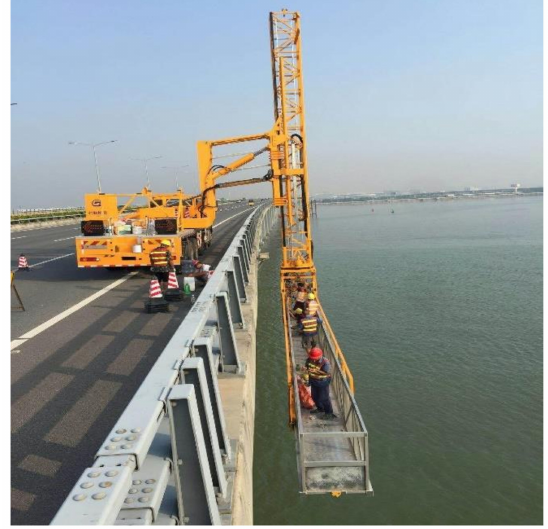
Figure 1. Manual bridge crack